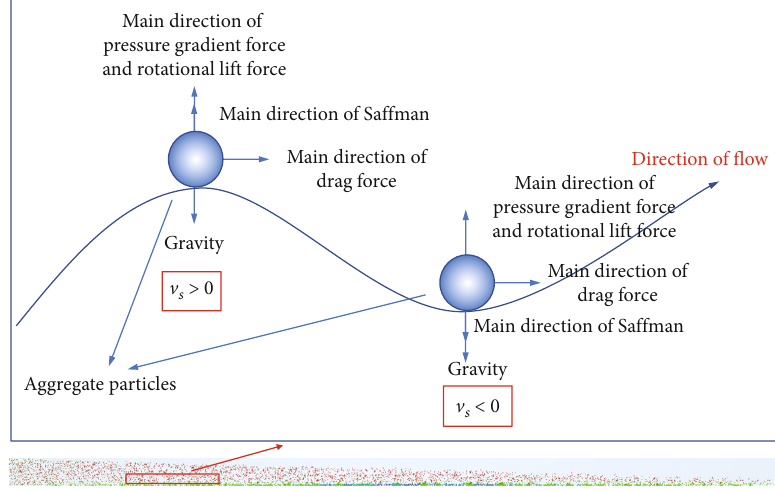
Figure 1: Mechanical analysis diagram of single aggregate